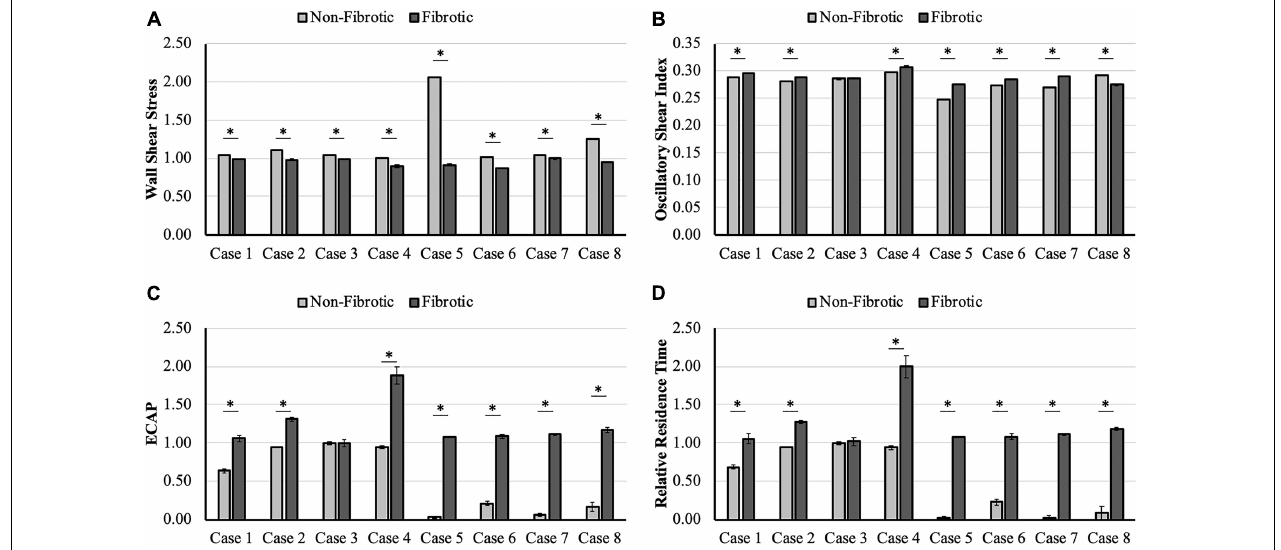
FIGURE 2 | Case-wise comparison of (A) wall shear stress (WSS), (B) oscillatory shear index (OSI), (C) endothelial cell activation potential (ECAP), and (D) relative residence time (RRT) between the fibrotic and non-fibrotic left atrial (LA) wall, showing lower WSS and higher OSI, ECAP, and RRT in the fibrotic region as compared to the non-fibrotic region of the LA wall for all cases. Cases marked with * have statistically significant differences; error bars represent standard error values.